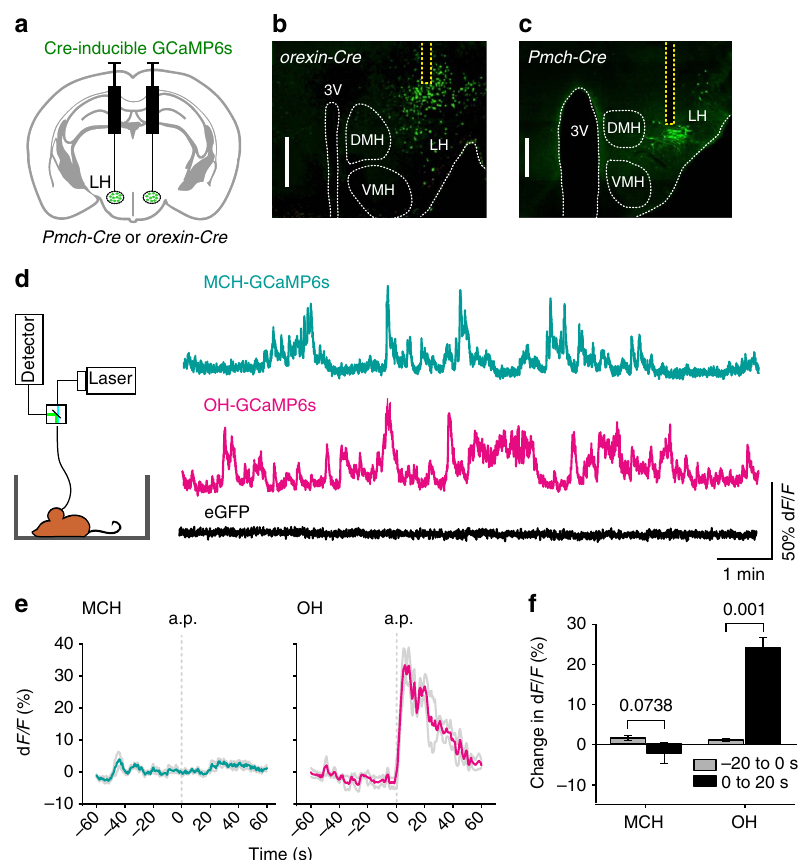
Figure 1 | Optical recordings from MCH and OH cells in awake freely moving mice ( a ) Scheme for targeting GCaMP6s expression. ( b , c ) Coronal brain slices from Pmch-Cre and orexin-Cre mice showing fibre locations (yellow dashed lines) and injection sites. DMH, dorsomedial hypothalamus; LH, lateral hypothalamus; 3V, third ventricle; VMH, ventromedial hypothalamus. Representative images of n ¼ 6 brains per group. Scale bars, 500 m m. ( d ) Left, scheme for fibre photometry. Right, calcium signals during cage exploration from mice expressing GCaMP6s in MCH neurons or GCaMP6s or eGFP in OH neurons (representative examples of n ¼ 4, 4, and 3 mice, respectively). ( e ) Calcium signals from mice expressing GCaMP6s in MCH and OH cells, aligned to application of tail air-puff (a.p.). Turquoise or magenta lines indicate means, grey lines indicate s.e.m., n ¼ 4 mice per group. ( f ) Quantification of data in e . Changes in fluorescence (means ± s.e.m., relative to values at (cid:2) 60s) that occurred before a.p. ( (cid:2) 20 to 0s) and after the a.p. (0 to 20s). Numbers above bars are P values from paired t -tests (MCH network: t , d.f. ¼ 0.367, 3; OH network t , d.f. ¼ 13.169, 3; n ¼ 4 mice per the 0.5–1.5 min after immobilization onset, fluorescence change relative to baseline at (cid:2) 2 min was (cid:2) 12.1 ± 2.4% for MCH cells and 19.9 ± 3.4% for OH cells; P ¼ 0.0003, two-tailed unpaired t -test; t , d.f. ¼ 7.652, 6; n ¼ 4 mice per group). These data further reveal differential modulation of MCH and OH networks on behaviourally relevant timescales across different sensory contexts.